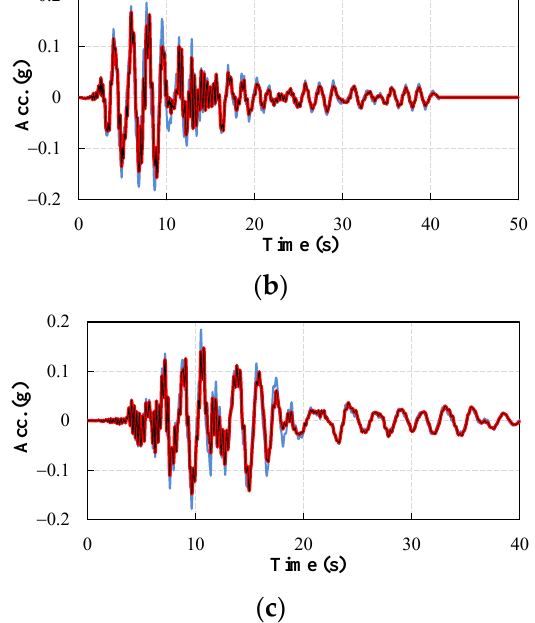
Figure 10. Accelerations of the 1st floor under the ground motions at a 2 – 3% PE in 50 years: ( a ) El Centro; ( b ) Kobe; ( c ) Northridge.